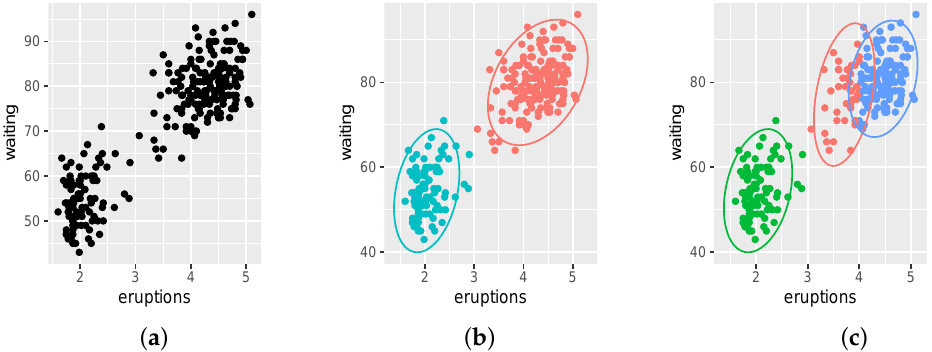
Figure 3. Old faithful dataset with two and three clustering schemes from estimated two- and three component Gaussian mixture models (GMM). ( a ) Old faithful dataset. ( b ) Two-component GMM. ( c ) Three-component GMM.